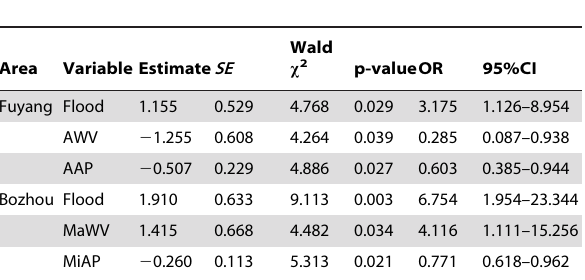
SE , standard error; OR, odds ratio; CI, confidence intervals. AWV, average wind velocity; AAP, average air pressure; MaWV, maximum wind velocity; MiAP, minimum air pressure.